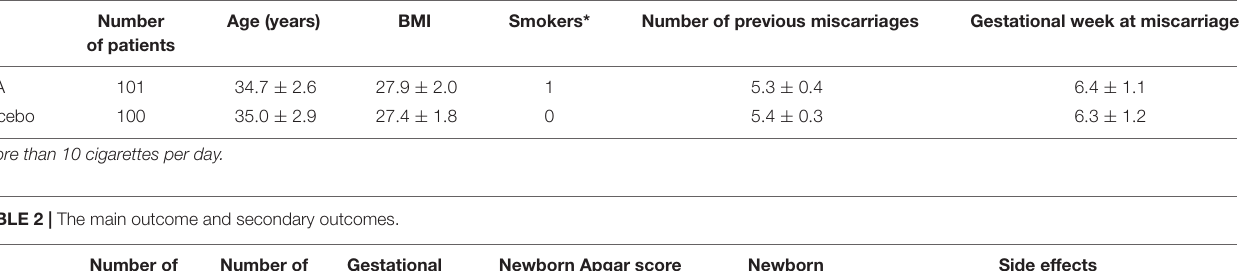
TABLE 1 | The basic information of the patients.